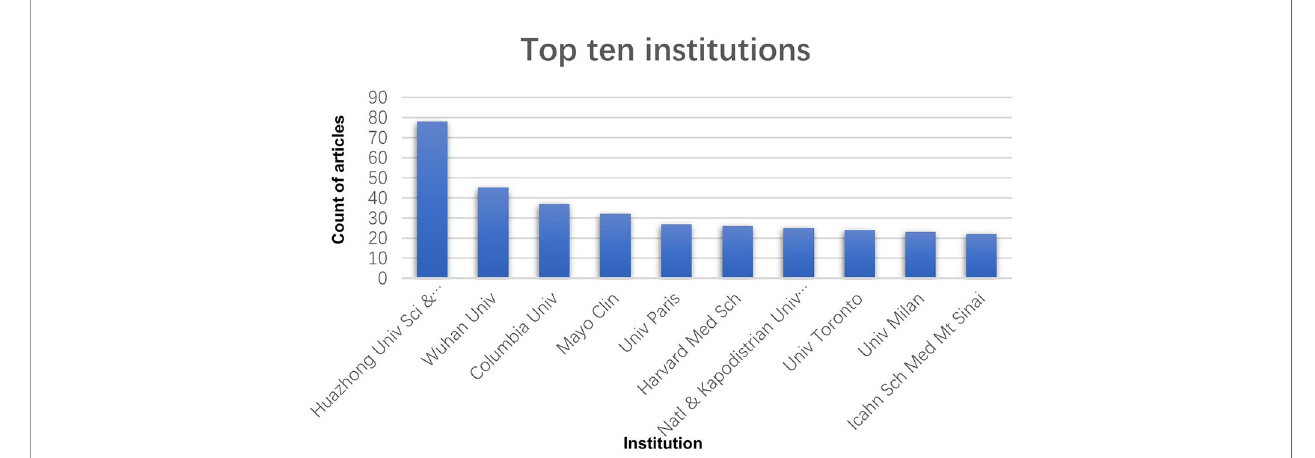
FIGURE 3 | The top ten institutions ranked in terms of the article counts.